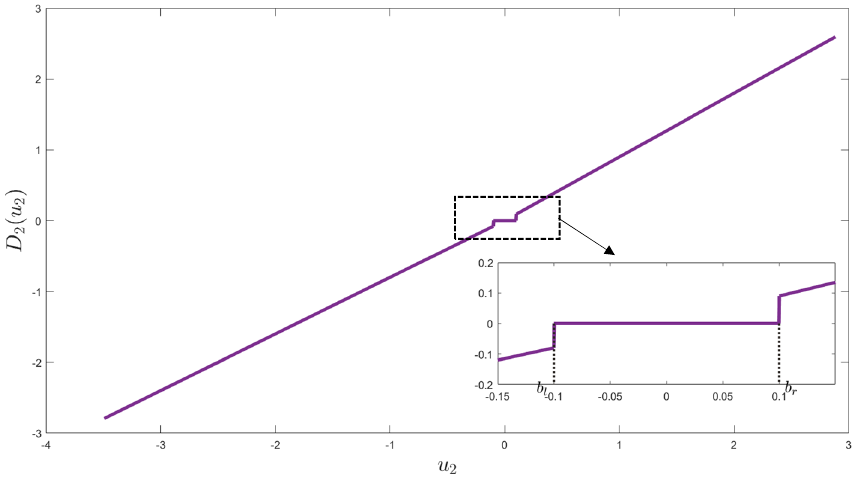
Figure 7. Control input u 2 with dead zone and the control